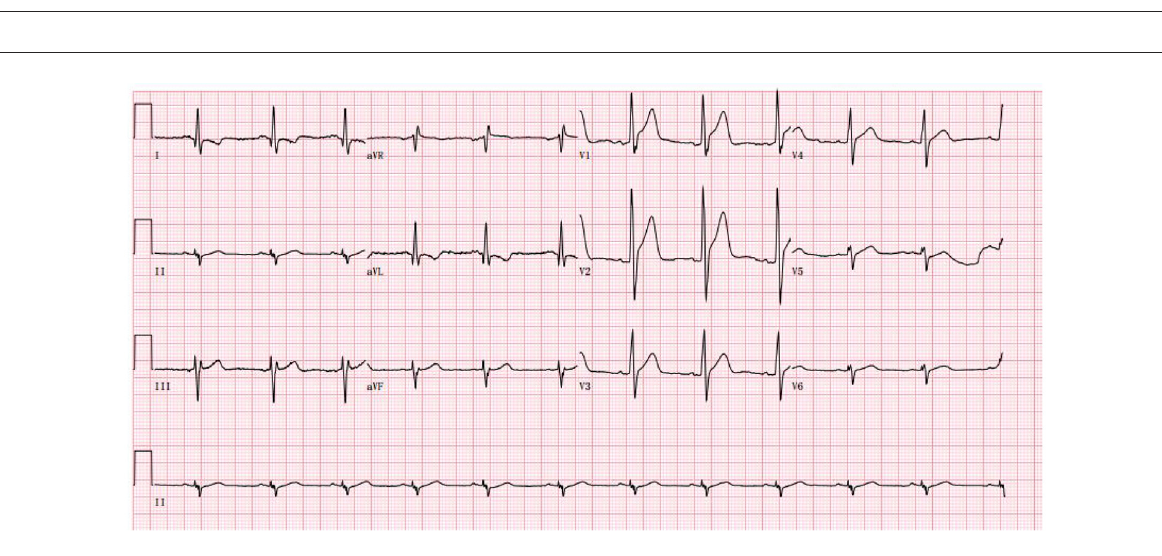
FIGURE3 The abnormal ECG at the admission in June 2022 (Sinus rhythm and tall R wave in V1V2V3, left anterior branch